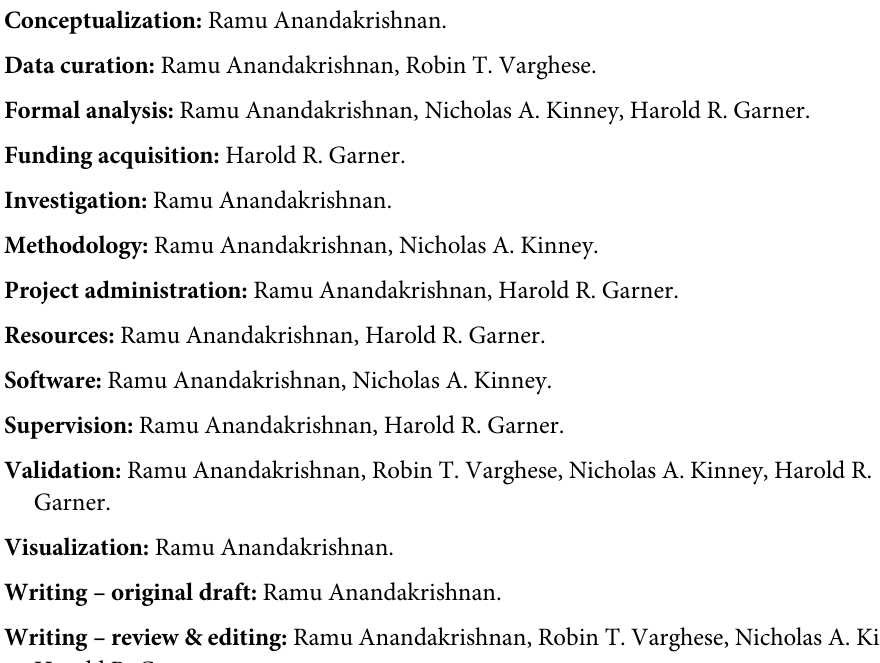
S2 Table. Results are robust for different values of G, the number of possible mutations. The estimated number of hits are the same when G is 8 times the value used for the results shown in Tables 1 and S1, except for uterine carcinosarcoma (UCS). S3 Table. Parameters for mechanistic model of tumor